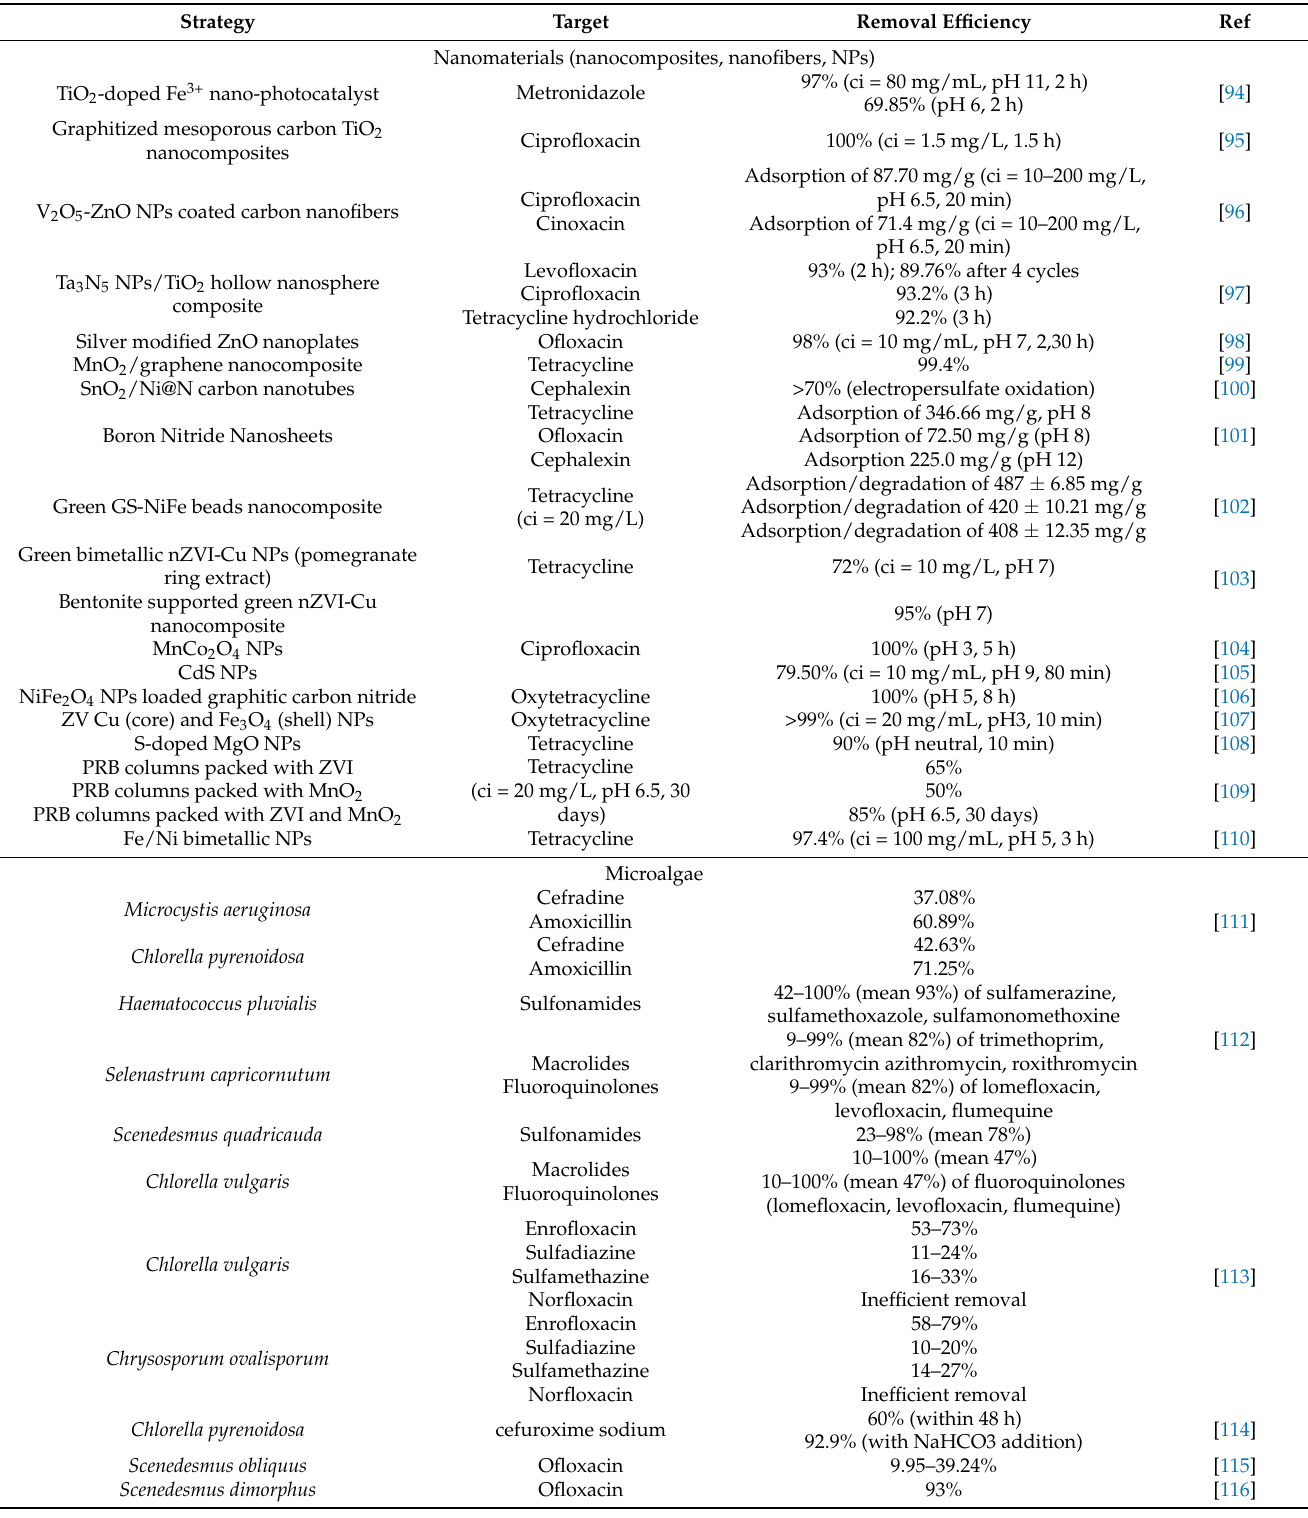
Table 2. Recent promising strategies to efficiently eliminate antibiotics in wastewater and drinking water treatment